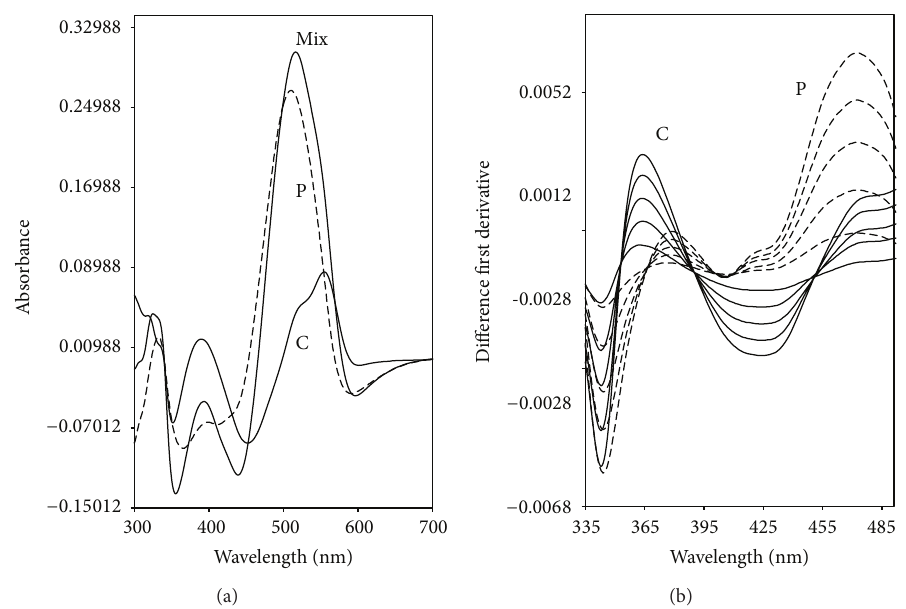
Figure 3: Difference absorption spectra of 10 𝜇 g mL −1 Carmoisine, 10 𝜇 gmL −1 Ponceau 4R and their binary mixture (a). Difference first derivative spectra (b) of colorants (Carmoisine: 2–10 𝜇 g mL −1 ; Ponceau 4R: 2–10 𝜇 g mL −1